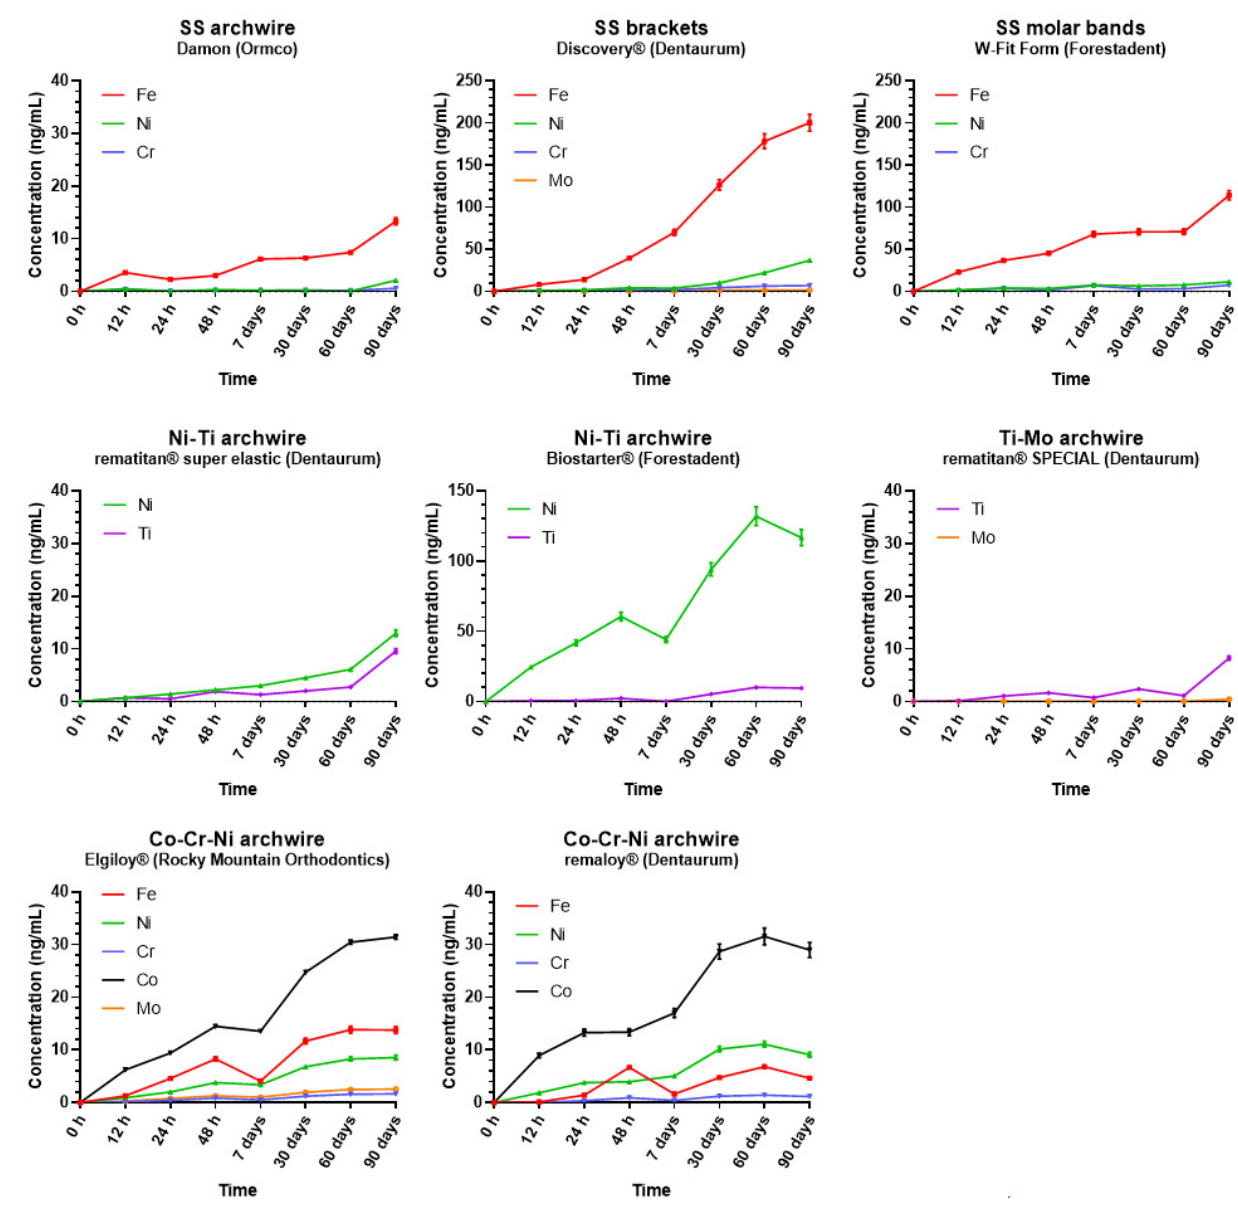
Figure 1. The release of metal ions from different parts of fixed orthodontic appliances into artificial saliva at different time points during the 90-day observational period. The results represent the average concentration of two parallel sam- ples with standard deviations.